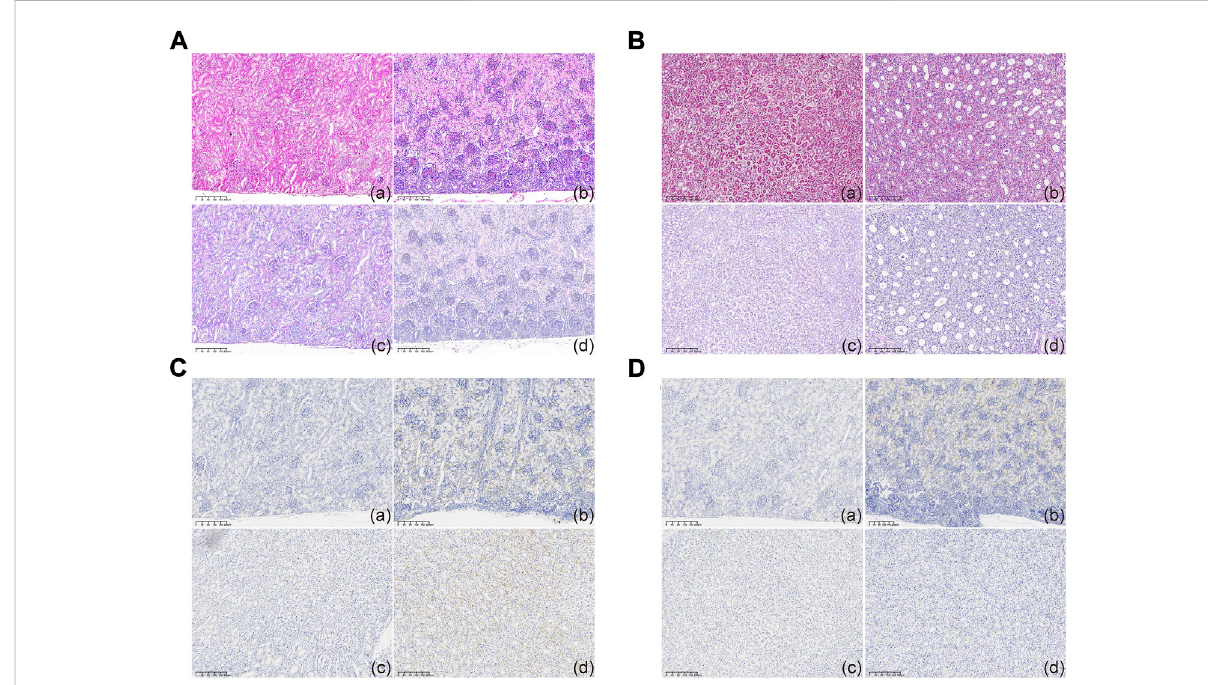
FIGURE 3 Histological examination of cloned piglets (A,B) Optical microscopy observation of the kidney tissues in the MU-hPKD2-02 and WT pigs. (C,D) Immunohistochemical characterization of the kidney tissues in the MU-hPKD2-02 and WT pigs. (a and c) MU-hPKD2-02. (b and d) WT pigs. (a,b) renal cortex. (c,d)